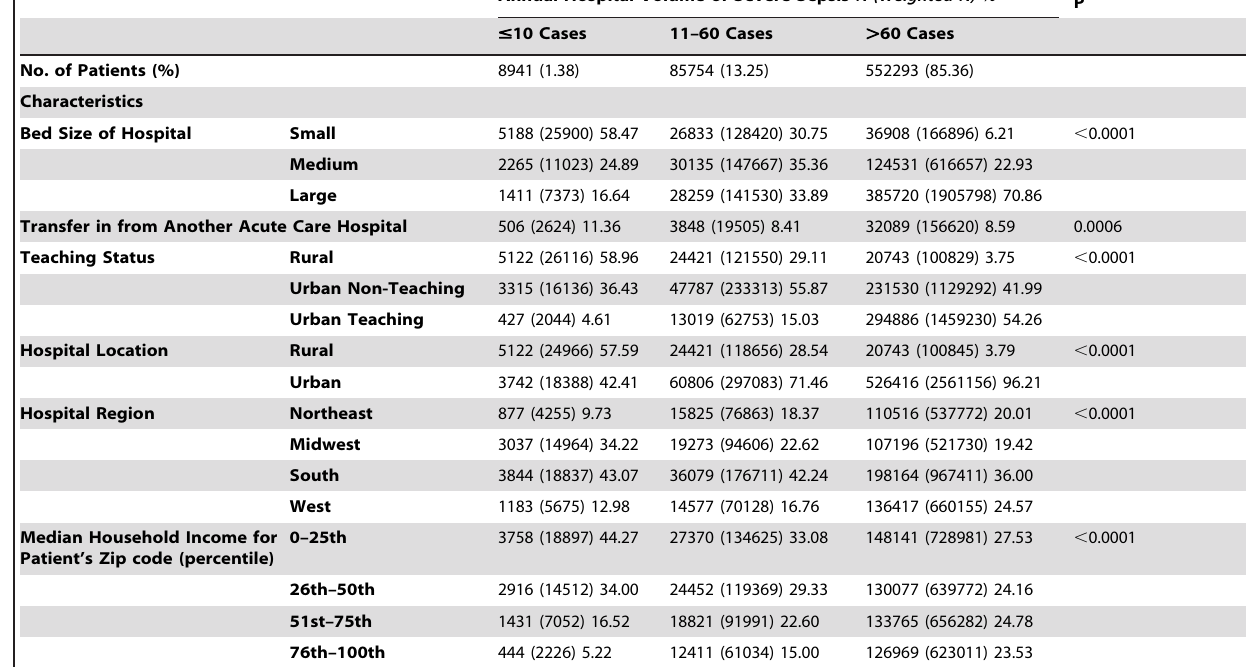
Table 2. Hospital characteristics.